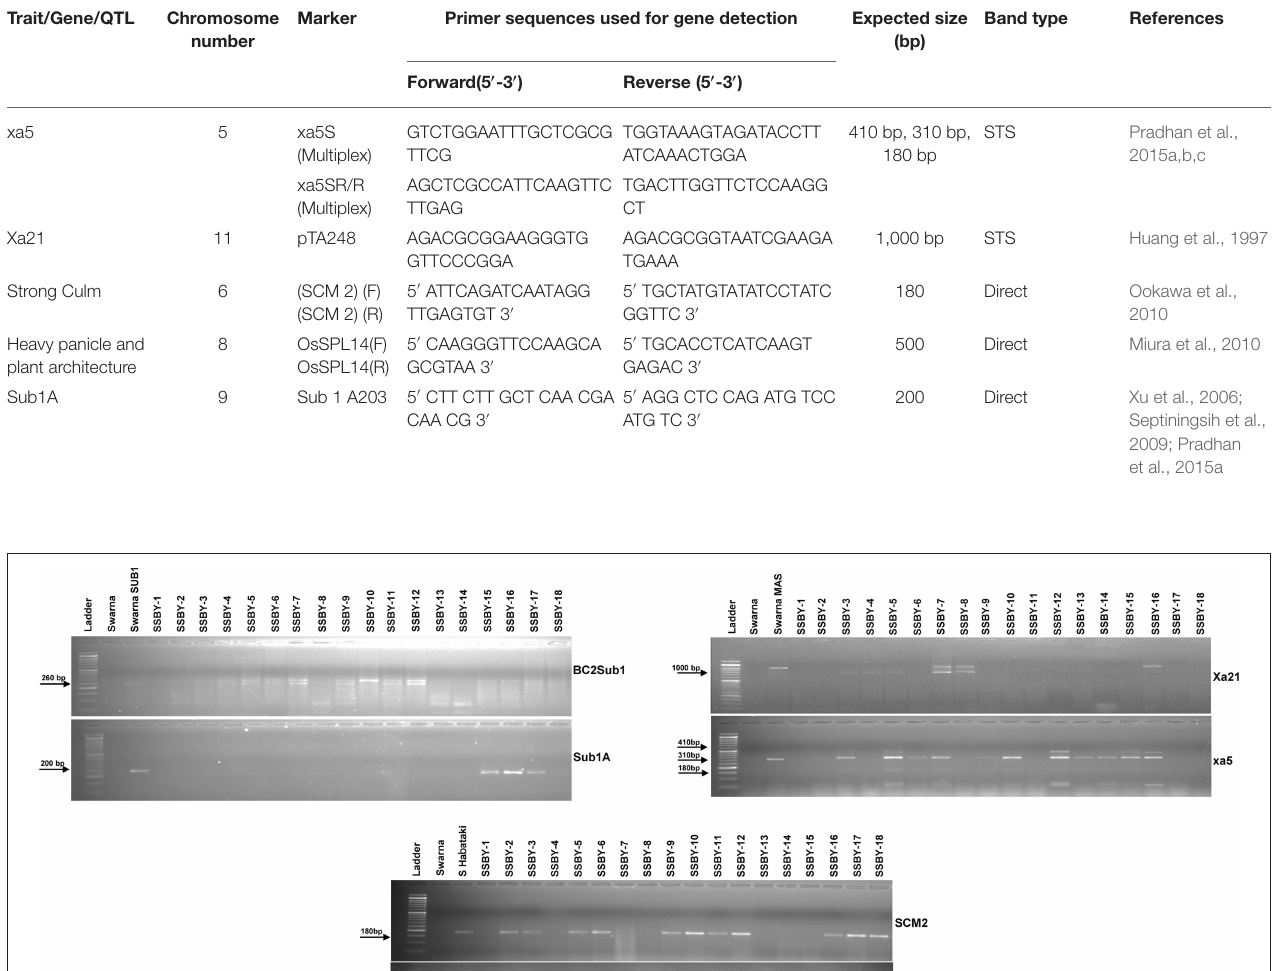
Phenotyping for Culm Strength of the Pyramided and Parental Lines The 11 pyramided lines and the parental lines were phenotyped for culm strength during the wet seasons, 2019, 2020, and 2021. The internodes from the top third and fourth were cut and bending strength at breaking (BL), and the physical strength of the culm was quantified using a physiological culm strength meter. The inner and outer diameters of the upper and lower end of both the internodes 3 and 4 were measured to calculate the radius of the culm. The culm radius was calculated by subtracting the inner diameter from the outer diameter and dividing it by two. Phenotyping for culm strength was performed as per the earlier publication of Nomura et al.